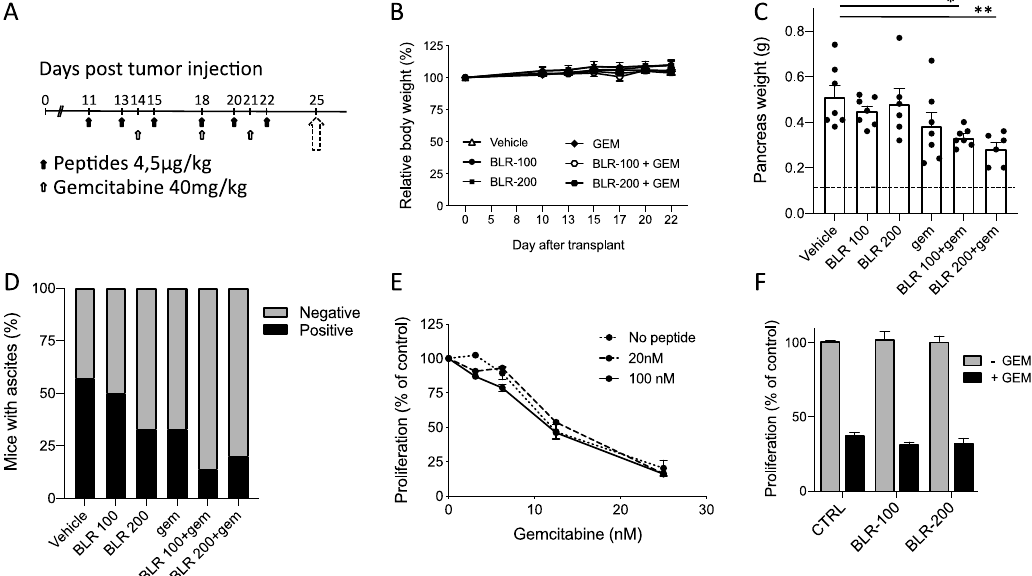
Figure 4. Antineoplastic activity of BLR100 or BLR200 in combination with gemcitabine on PDAC. ( A ) Schedule of treatment. Mice received the peptides (black arrows) and gemcitabine (white arrows) at the indicated times. Dotted arrow indicates mice sacrifice and tumor analysis. ( B) E ff ect of the indicated treatments on mouse body weight. Data are expressed as relative body weight, the percentage of mouse weight at the beginning of treatment, mean ± SEM. ( C ) Tumor burden (pancreas weight) in mice bearing FC1199 orthotopic tumors treated with vehicles, peptide BLR100, peptide BLR200, gemcitabine (gem), or gemcitabine in combination with the peptides. Dotted line: weight of pancreas in healthy mice (n = 7, mean ± SEM, One way ANOVA and Dunnett’s * p < 0.05, ** p < 0.005). ( D ) E ff ect of treatments on ascites formation. Data are the percentage of mice presenting (black) or not (gray) ascites (n = 7). ( E , F ) BLR100 and BLR200 did not a ff ect FC1199 cell response to gemcitabine in vitro. ( E ) Proliferation of FC1199 cell exposed to increasing concentrations of gemcitabine alone or with the peptide (20 and 100 nM). ( F ) Inhibition of FC1199 cell proliferation by gemcitabine (15 nM) in the presence of BLR100 or BLR200 (100 nM). Data are percentage of control, from one experiment representative of